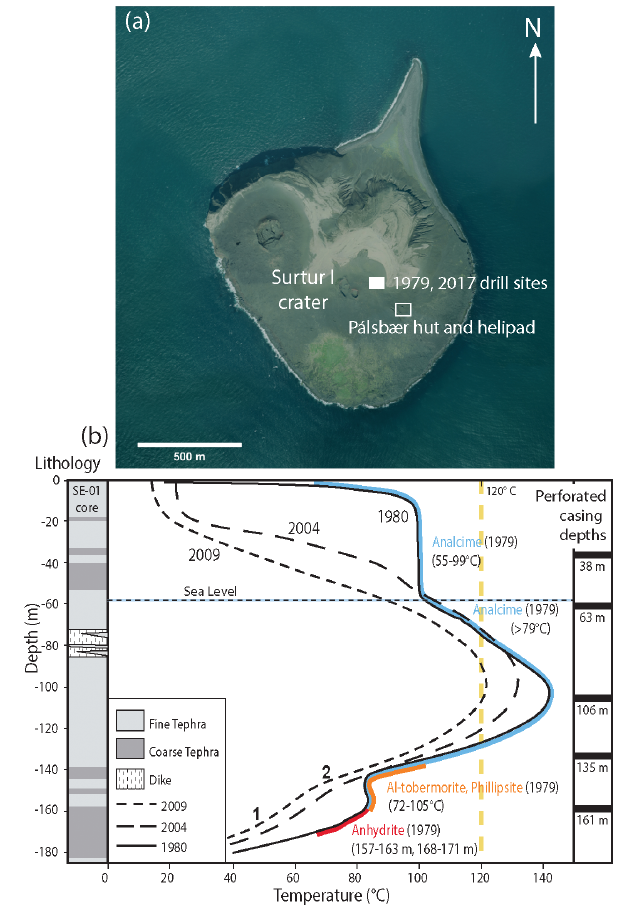
Figure 1. Setting of the Surtsey subsurface observatory in the 5059- 1-C (SE-02b) cored borehole (latitude 63 ◦ 18.09739 (cid:48) N, longitude 20 ◦ 35.99020 (cid:48) W). (a) Aerial photograph of Surtsey, 26 July 2016 (courtesy of Loftmyndir ehf.); (b) temperature profile of the 1979 SE-01 cored borehole (after Jakobsson and Moore, 1986; Jackson et al., 2015) showing the 2009 site 1 and site 2 microbial commu- nities (Marteinsson et al., 2015) and depths of the perforated casing segments. The yellow dashed line indicates the upper limit for func- tional microbial life, at about 121 ◦